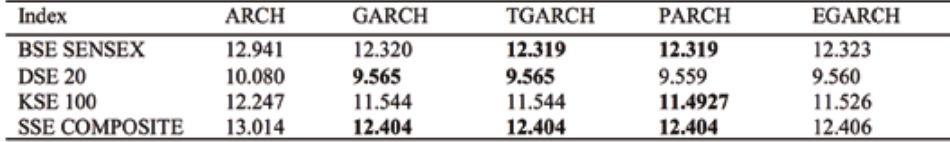
Table 3a: Model Selection Criterion – Akaike Information Criterion